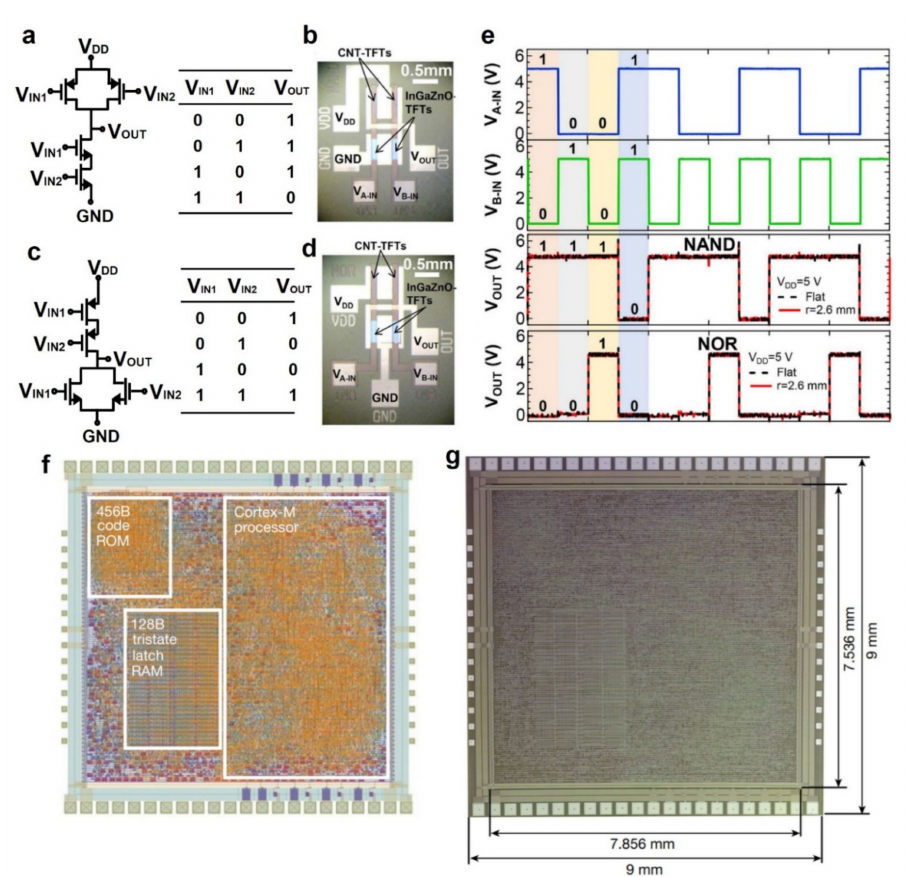
Figure 7. ( a ) Schematic diagrams of the NAND structure and the truth table; ( b ) Microscopic image of flexible NAND structure; ( c ) Schematic diagrams of the NOR structure and the truth table; ( d ) Microscopic image of the flexible NOR structure; ( e ) Input and output signal for the NAND and NOR logic circuits (adapted from [106] with permission from Springer Nature); ( f ) Layout of the PlasticARM, including Cortex-M processor, ROM, and RAM; ( g ) Microscopic image of the PlasticARM (adapted from [107] with permission from Springer